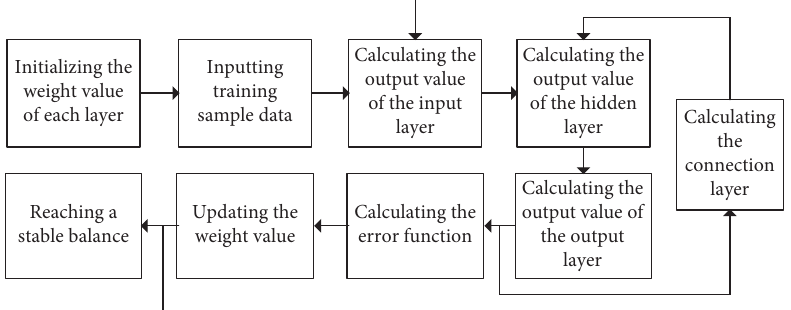
Figure 2: Elman neural network operation